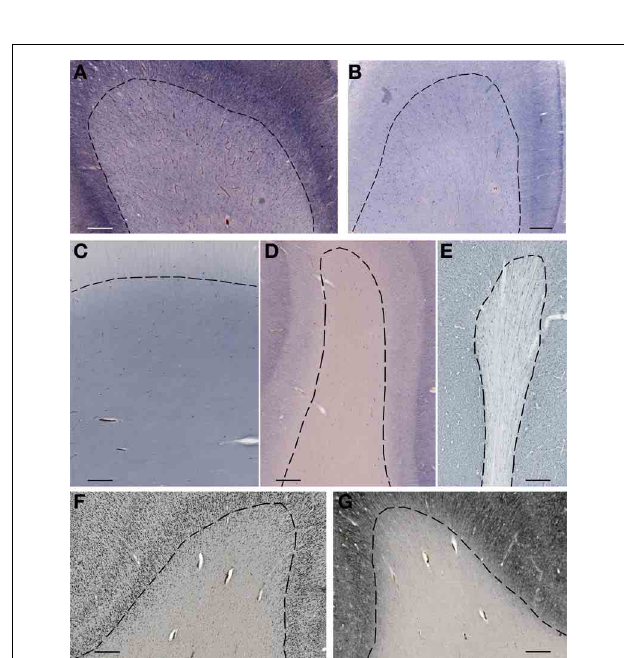
FIGURE 4 | Subplate and white matter interstitial neurons stained for NOS (NADPH-diaphorase-stained neurons in A–D), MAP2 (E,G) and NeuN (F) are visible throughoutthe subplate (A,B) and the white matter (C–G). Note that subplate/white matter interstitial neurons are numerous even after the first year of life, when subplate zone disappears. (A) , 37PCW; (B) , 13 days; (C) , 12 years; (D) , 57 years; (E,G) , 13 months; (F) , 51 years. Bar = 1mm.